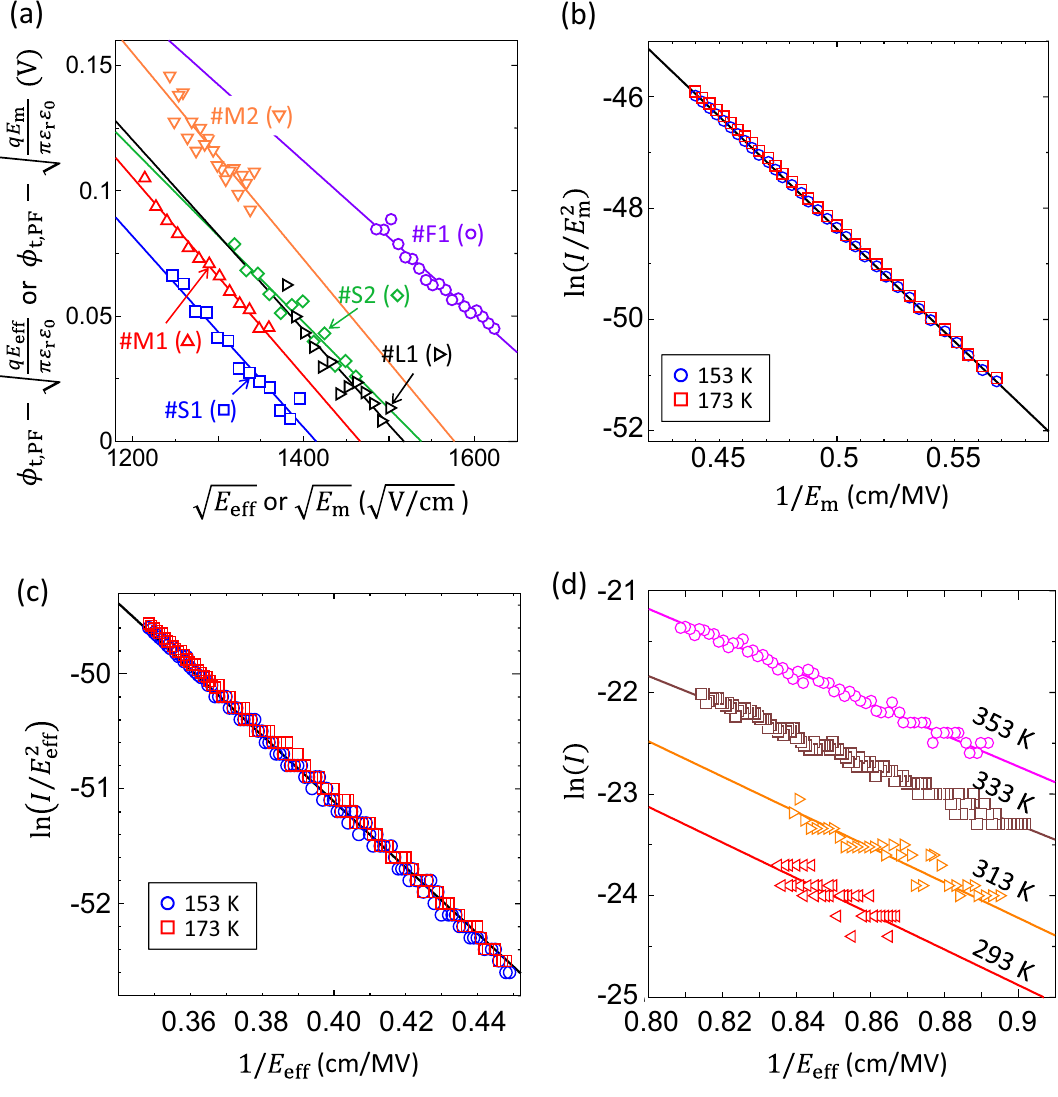
qE m /πε r ε 0 vs. √ E m or φ t,PF qE eff /πε r ε 0 vs. √ E eff plots for data obtained in Figure 7. ( a ) φ t,PF − − temperature range (B) for the #F1, #S1, #S2, #M1, #M2 and #L1 pits. ( b ) ln( I / E m 2 ) vs. 1/ E m plots for the #F1 site (cid:31) (cid:31) and (c) ln( I / E eff 2 ) vs. 1/ E eff plot for the #L1 pit. ( d ) ln( I ) vs. 1/ E eff plots for data obtained in temperature region (C) for the #M2 pit. Solid lines in (a) and (d) represent the best fits to each data set while those in ( b ) and ( c ) are